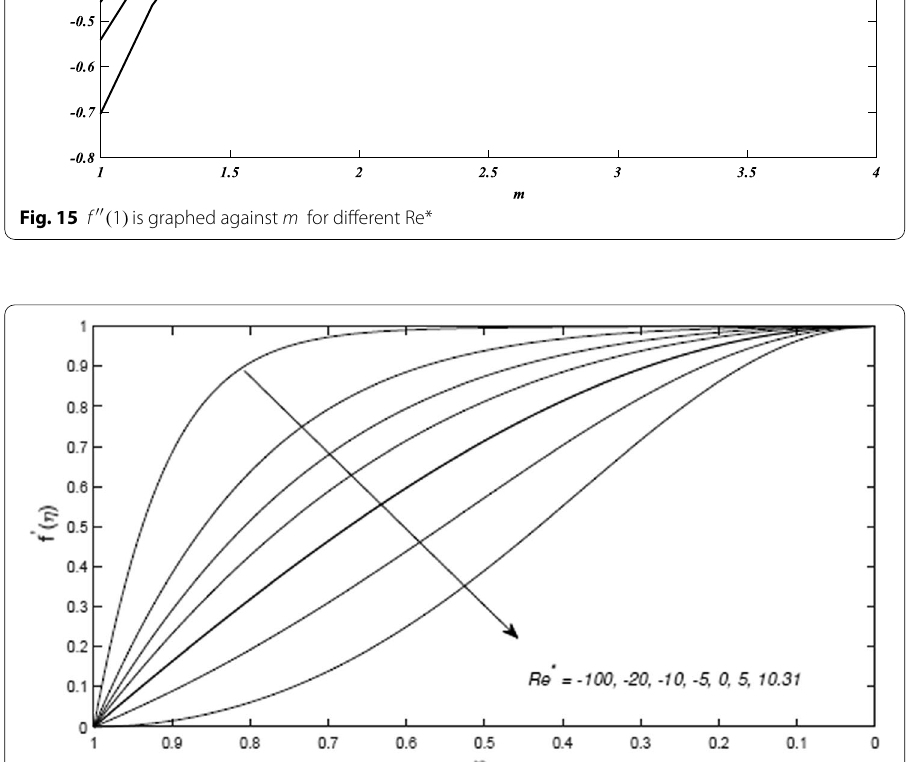
Fig. 16 f ′ is plotted against η for different values of Re*